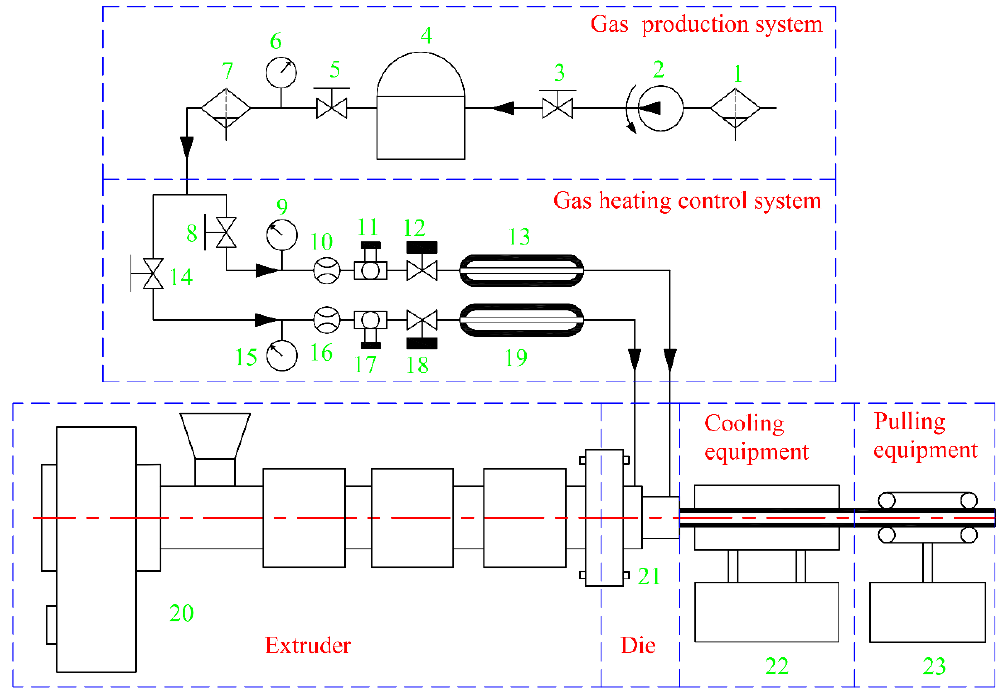
Figure 9. The double-layer gas-assisted extrusion experimental platform. 1,7—Filter; 2—Air compressor; 3,5,8,14—Switch valve; 4—High pressure storage tank; 6,9,15—Pressure gauge; 10,16—Flow meter; 11,17—Pressure regulating valve; 12,18—Flow regulating valve; 13,19—Gas heater; 20—Extruder; 21—Extrusion die; 22—Cooling device; 23—Traction device.